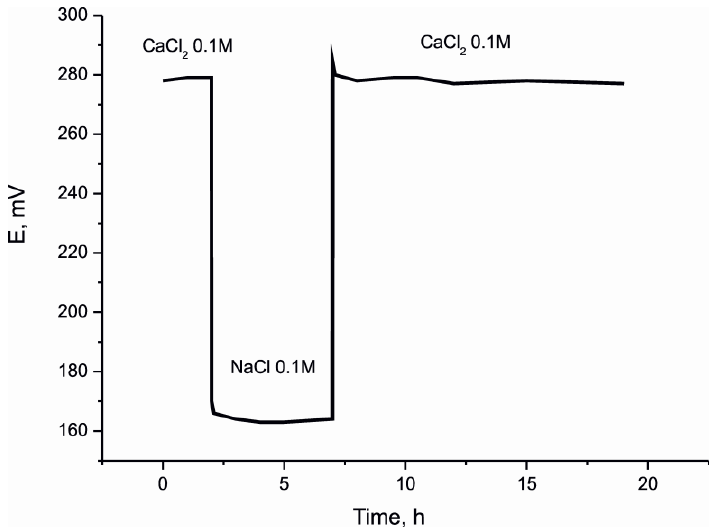
Figure 5. Aqueous layer test in 0.1 M primary ion (Ca 2+ ) and interfering ion (Na + )